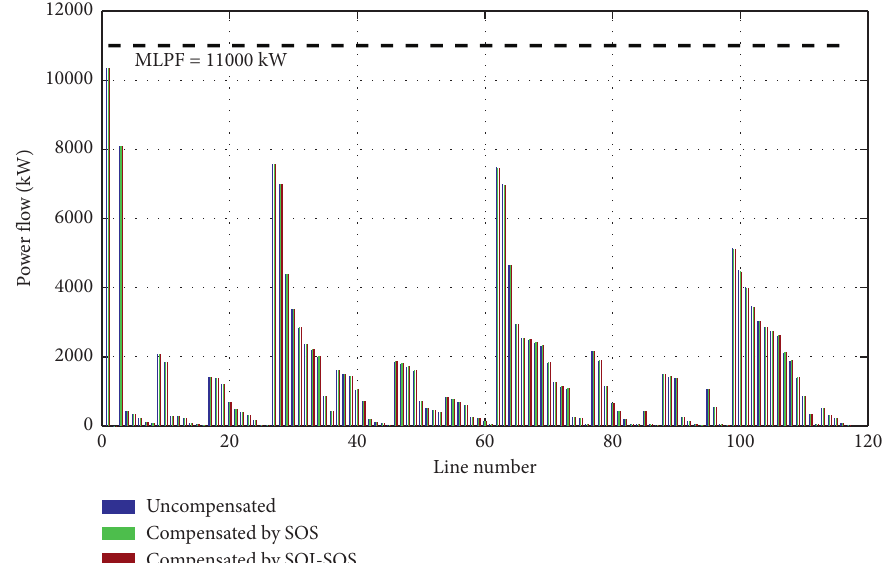
Figure 22: Comparison of lines power flow of the 119-bus system before and after compensation with the mixed load